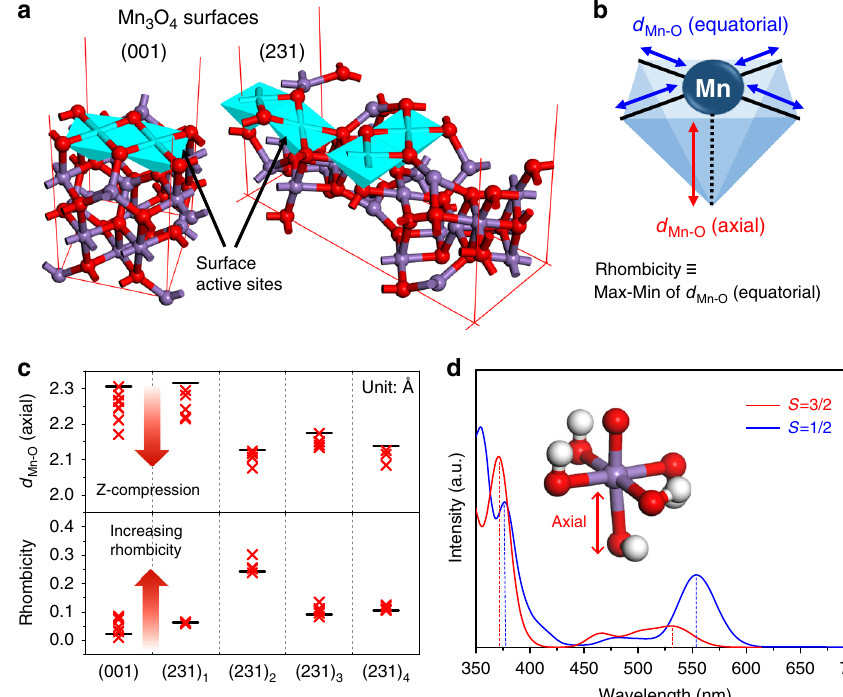
Fig. 7 DFT calculations to evaluate the effect of Ni substitution. a Atomic structures of Mn 3 O 4 (001) and (231) surfaces used in periodic DFT calculations. b Schematic illustration of the surface Mn active site with the de fi nition of rhombicity. c The effect of Ni substitution on the axial Mn – O distance and rhombicity of equatorial Mn – O distances of the Mn 3 O 4 (001) and (231) surface active sites. Here, rhombicity is quanti fi ed as the difference between the shortest and longest equatorial Mn – O bonds. d Calculated UV-Vis spectra of the high-spin and low-spin Mn(IV) site cluster models (inset) showing